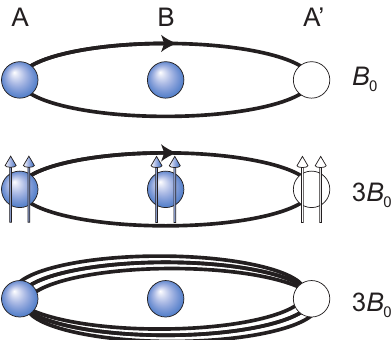
Figure 1. Two electrons A and B mutually interchange their positions on the plane at a magnetic field and a cyclotron orbit fits to the separation of nearest electrons in the Wigner lattice. The relative trajectory in magnetic field is shown—electron A traverses a relative cyclotron trajectory around electron B. Half of this trajectory, when the electron A takes the position A’, corresponds to a braid and the interchange of A and B electrons is completed—the phase shift of the wave function is π . In the upper panel the interchange of A and B electrons can be made along ordinary cyclotron orbit for field B 0 , like in the case of IQHE. In the central panel, this interchange is proposed for CFs for FQHE at ν = 1 (for field 3 B 0 ), i.e., for electrons with two flux quanta of some fictitious 3 field attached. The fictitious field reduces the external field 3 B 0 to B 0 and electrons A and B can interchange. The phase shift for the half of this trajectory is 3 π , due to the Aharonov-Bohm-type effect. In the bottom panel the real structure of the cyclotron orbit and the braid (the half-piece of the cyclotron orbit) is shown for the external field 3 B 0 —two additional loops are effectively modeled by two flux quanta added to CFs (as in the central panel). The phase shift for the transition described by the braid here is 3 π according to the unitary representation of the braid. Three-loop cyclotron orbit is larger than singleloop which is too short at 3 B 0 and the three-loop orbit fits to the separation of nearest electrons in Wigner lattice (cf. Appendix